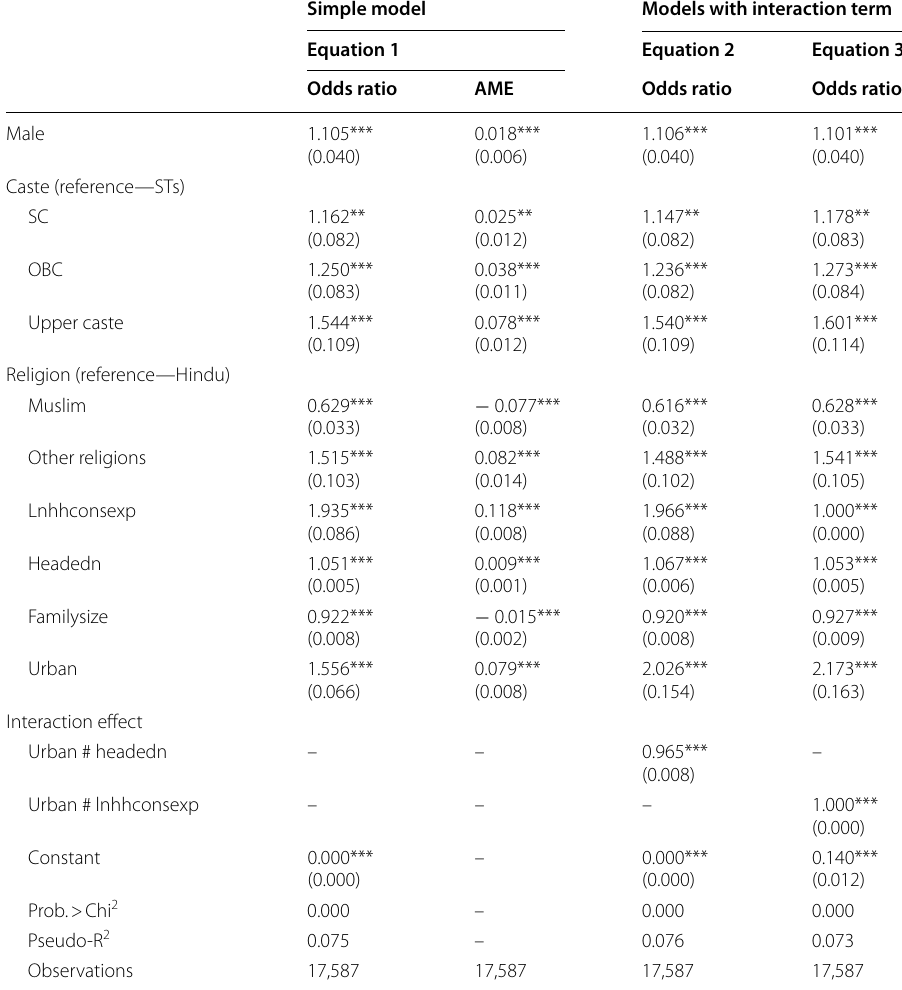
Table 4 Predicted probability of attending pre-primary education (3–5 years): logit